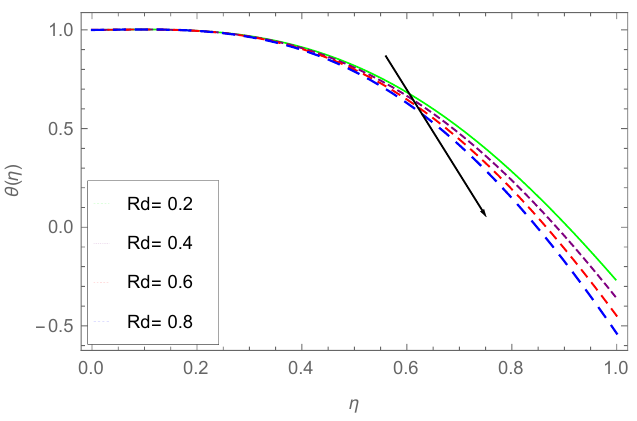
Figure 8. Impact of Rd on θ ( η ) , for β = 0.1, St = 0.1, Nt = 0.6, Nb = 0.5.